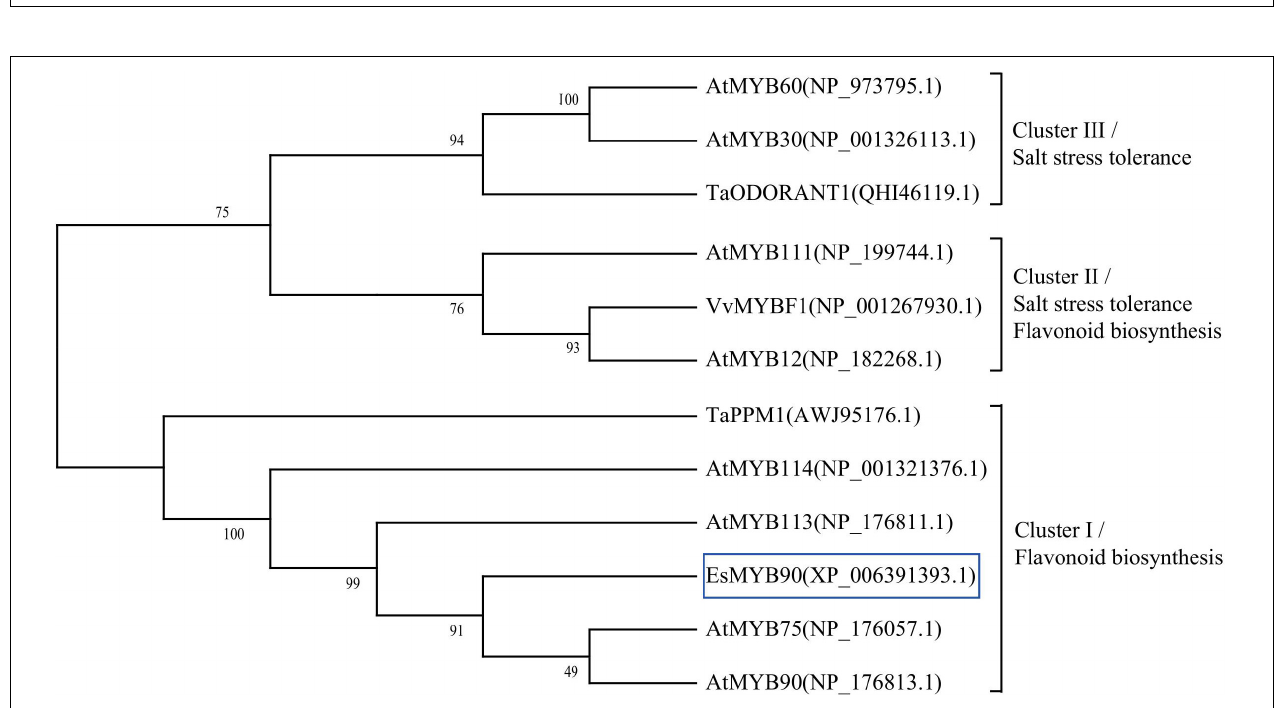
FIGURE 10 | Phylogenetic analysis of EsMYB90 and the other 11 MYB proteins in plants. EsMYB90 is highlighted with a blue box. The MYB protein sequences were downloaded from the GenBank database with accession numbers shown in the diagram.